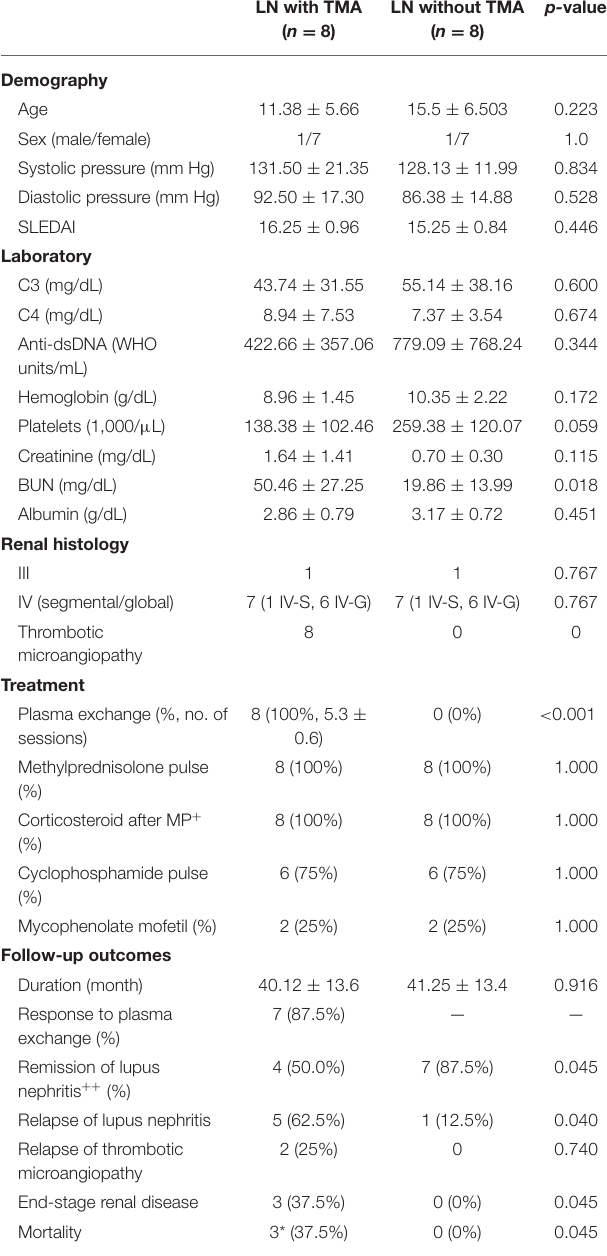
TABLE 1 | Clinical characteristics of lupus nephritis patients with and without thrombotic microangiopathy.